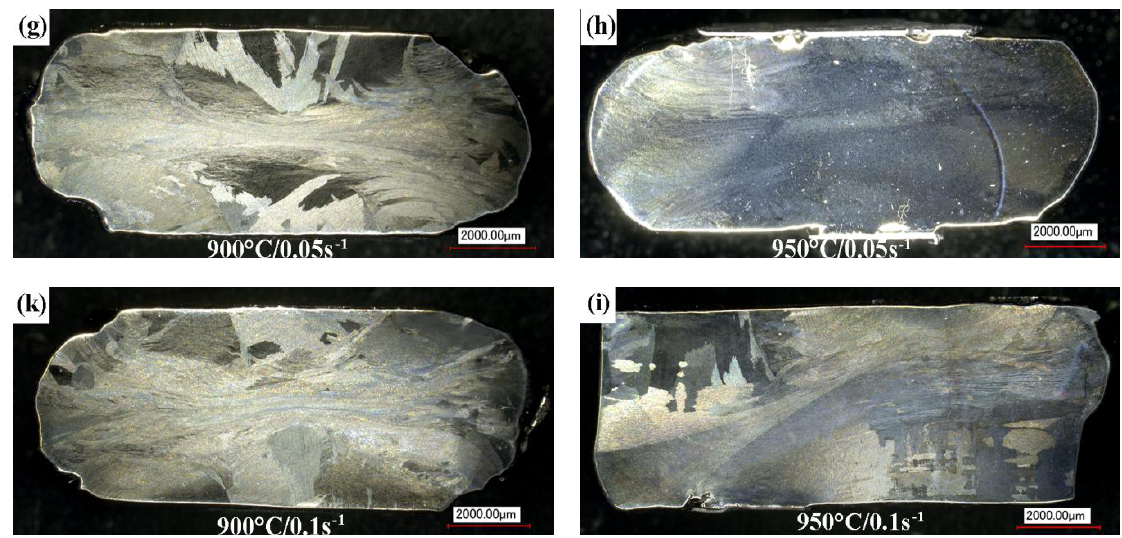
Figure 4. Macro pictures of Ti-6Al-4V sample deformed at ( a ) 900 °C/10 −3 s −1 , ( b ) 950 °C/10 −3 s −1 , ( c ) 900 °C/5 × 10 −3 s −1 , ( d ) 950 °C/5 × 10 −3 s −1 , ( e ) 900 °C/10 −2 s −1 , ( f ) 950 °C/10 −2 s −1 , ( g ) 900 °C/5 × 10 −2 s −1 , ( h ) 950